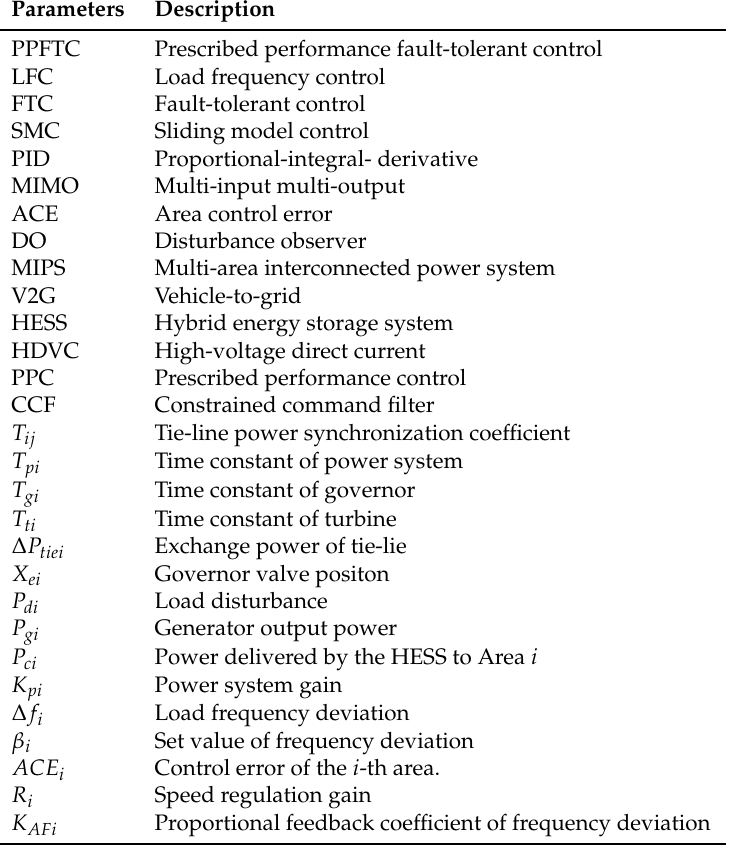
Table 1. The symbols and acronyms used in the